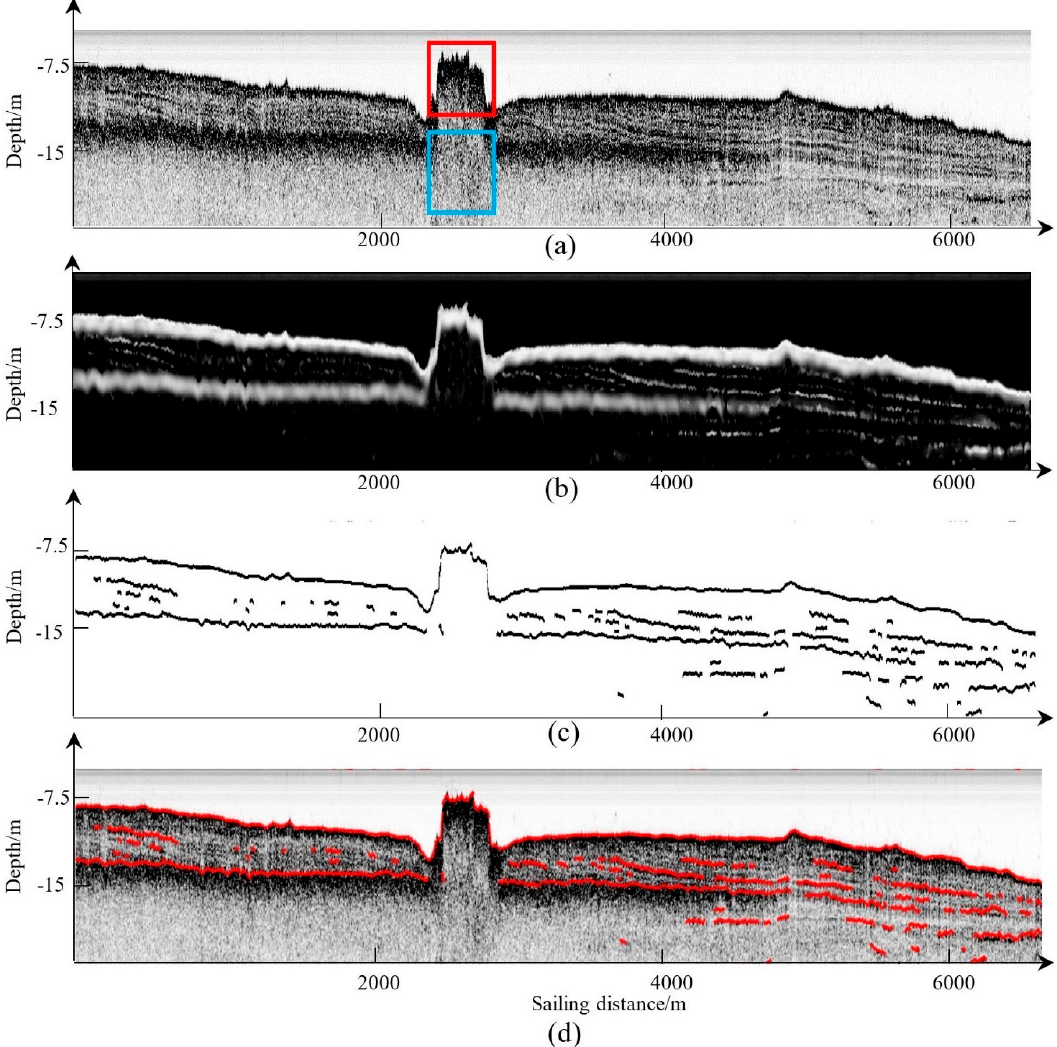
Figure 9. The original SBP image and the resulting images. ( a ) shows the original SBP image. ( b ) shows the filtered image. ( c ) shows the picked horizon result from ( a ), and ( d ) shows the superposition of the picked horizons and the original SBP image. The structures in the blue rectangle are vertical structures. The area marked with a red rectangle is an underwater tunnel.